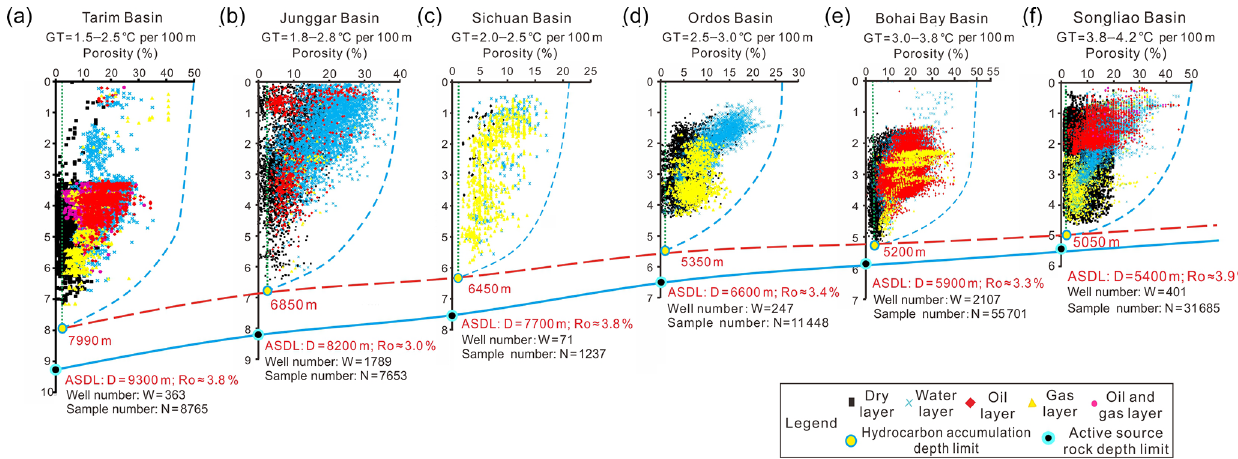
Figure 7. Hydrocarbon drilling results in the six representative petroliferous basins of China to show their relationships with the ASDLs and the HADLs. The results include 116489 samples of target layers from 4978 exploration wells in China. The blue dashed line represents the evolution of porosity with depth. Its intercept with the line of 2% porosity marks the HADL. The ASDL of each basin shown in this figure is represented by the value obtained from hydrocarbon generation potential index (“ S 1 + S 2 ” / TOC) of each basin. From left to right: (a) Tarim Basin. (b) Junggar Basin. (c) Sichuan Basin. (d) Ordos Basin. (e) Bohai Bay Basin. (f) Songliao Basin. It is clear that the HADLs are always above the ASDLs.